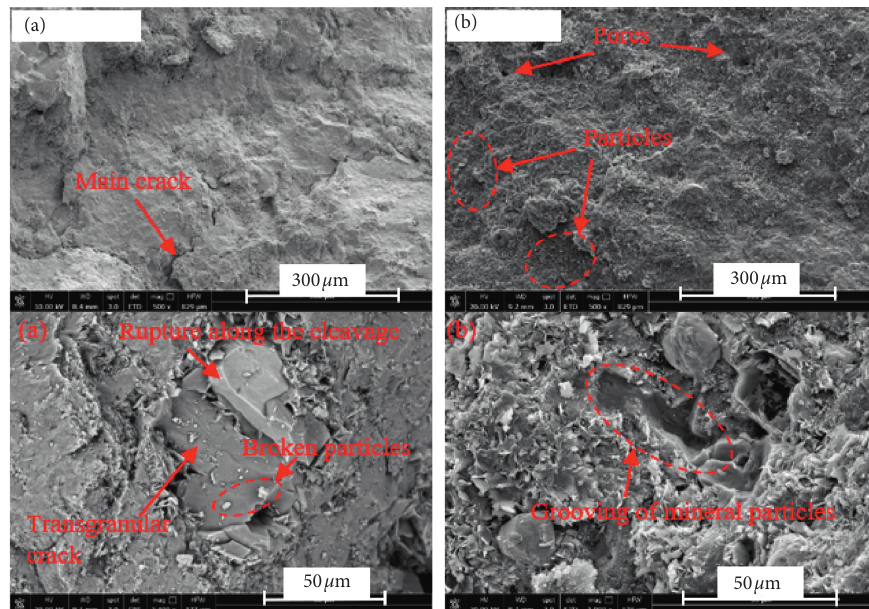
Figure 10: Microfracture characteristic pattern of the tuffs in the tunnel of Mila Mountain after uniaxial compression. (a) DRY 3. (b)